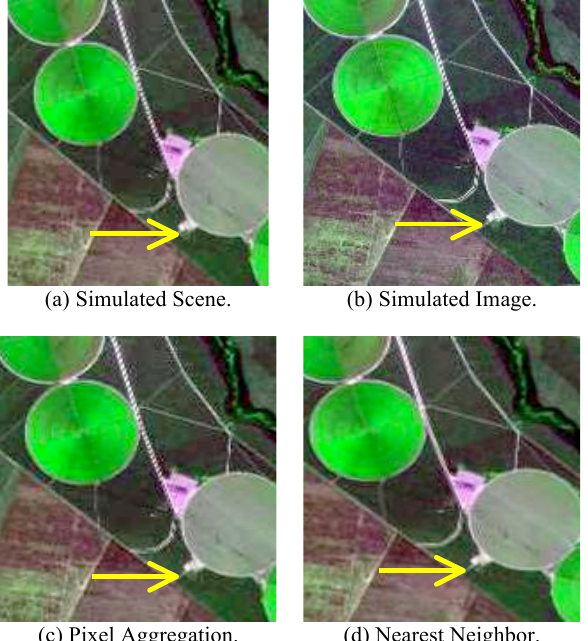
Figure 3. Resampling